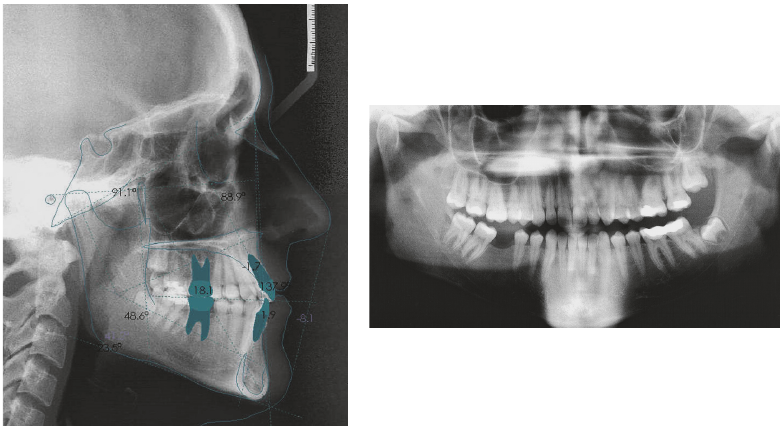
Figure 2: Lateral and panoramic initial radiographies.